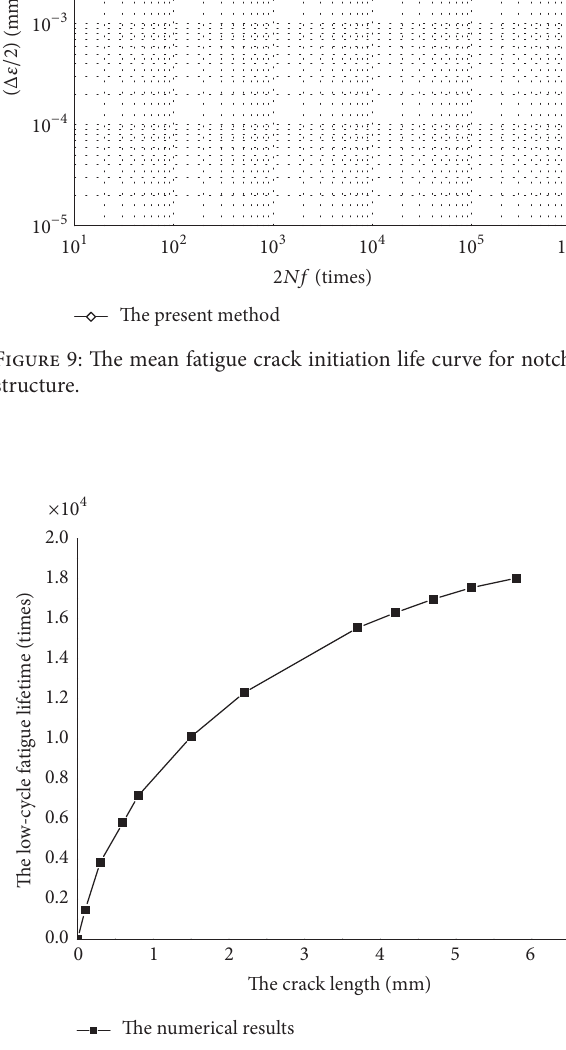
Figure 10: The crack propagation curve for notched structure.